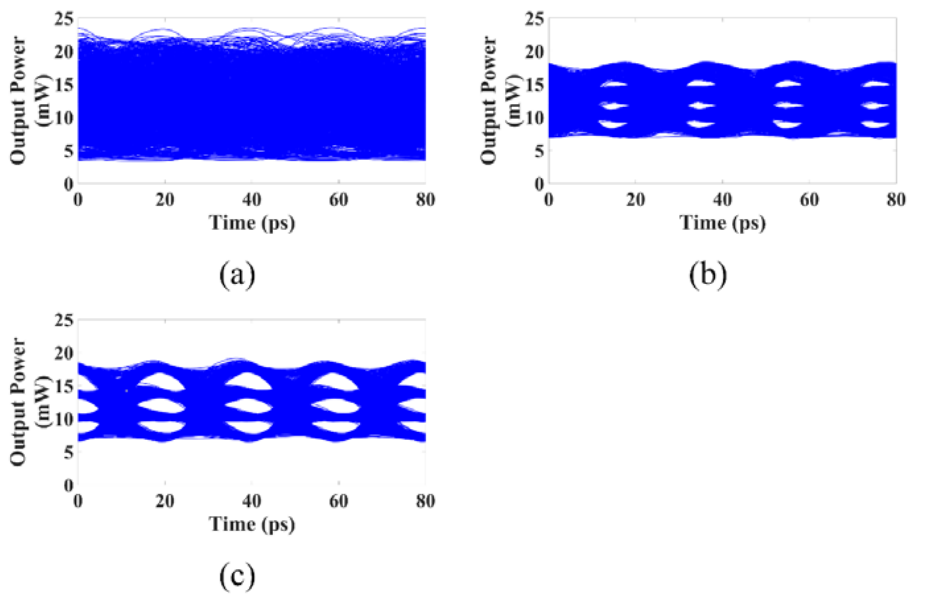
Figure 10. The 50 Gbps NRZ eye diagram with P bias = 12 mW: ( a ) Conventional DML; ( b ) PPM-DFB laser; ( c ) DPPM-DFB laser.